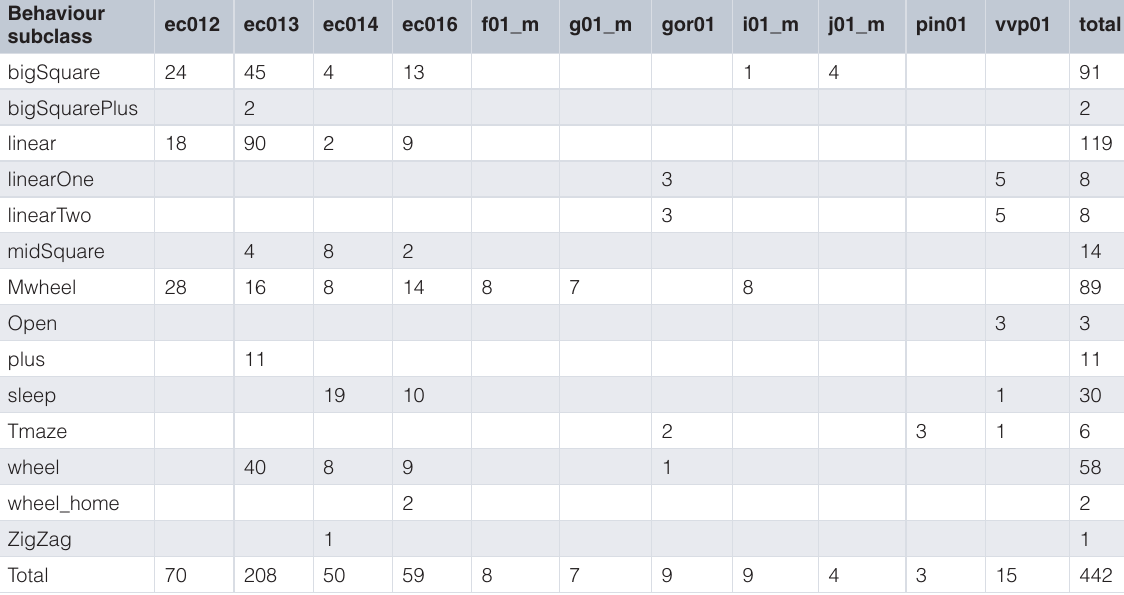
Table 5. Number of recording sessions. Top row: animal identifier. Left column: behaviour subclass. Behaviour